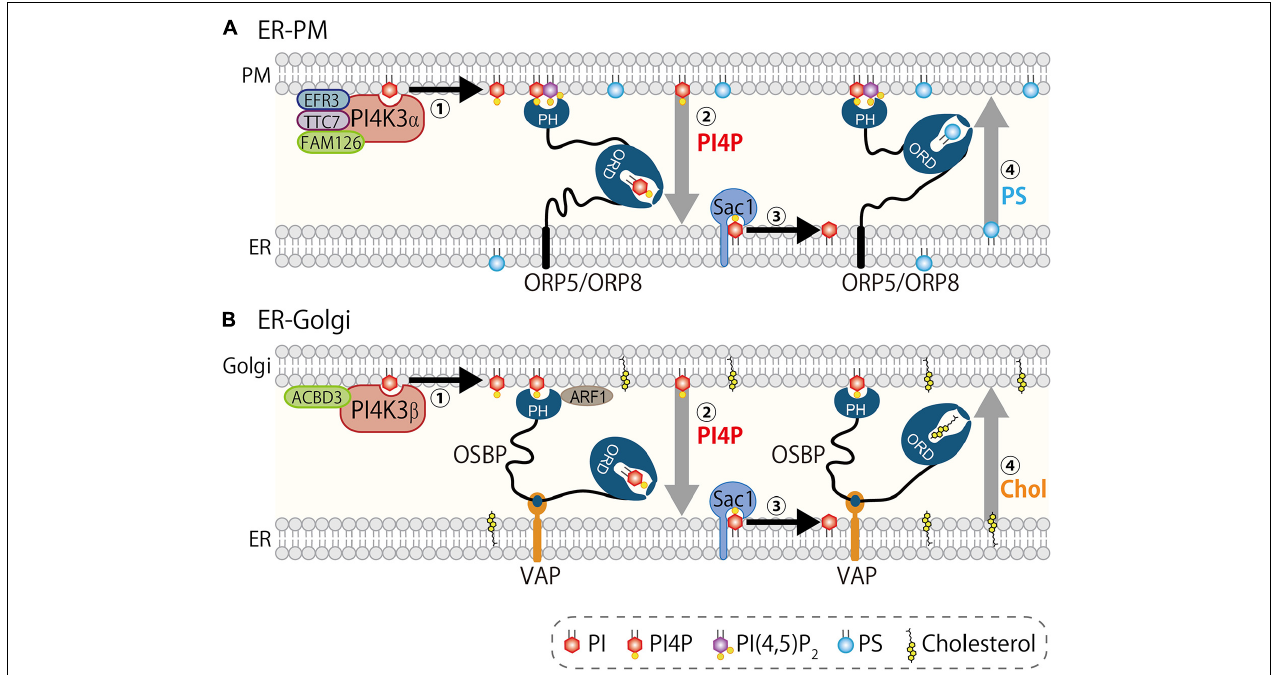
FIGURE 3 | PI4P-driven lipid countertransport at MCSs. PI4P drives lipid countertransport mediated by ORP5/8 at ER–PM MCSs (A) and by OSBP at ER–Golgi MCSs (B) . (A) PI4K3 α complex including EFR3A/B, TTC7A/B, and FAM126A/B synthesizes and concentrates PI4P at the PM (step 1). ORP5/8, both of which are anchored to the ER, form MCSs via interaction with PI4P and PI(4,5)P 2 by PH domain, and transport PI4P (driver-ligand) from the PM to the ER (step 2). Sac1 dephosphorylates PI4P to PI, which keeps the concentration of PI4P low at the ER (step 3). ORP5/8 transport PS (cargo-ligand) from the ER to the PM. (B) PI4K3 β generates PI4P upon recruitment to the Golgi by regulatory proteins including Arf1 (step 1). Oxysterol-binding protein (OSBP) is recruited to the ER–Golgi MCSs via PH domain that interacts with PI4P and ACBD3 and/or Arf1 on the Golgi membranes and FFAT-motif that binds vesicle-associated membrane protein (VAMP)-associated protein A/B (VAPA/B). Then, OSBP mediates transport of PI4P (driver-ligand) from the Golgi to the ER (step 2). Sac1 hydrolyzes PI4P to PI (step 3). OSBP transports cholesterol (cargo-ligand) to Golgi (step 4). Synthesis and hydrolysis of PI4P by PI4Ks and Sac1 establishes a concentration gradient of this lipid between the ER and the PM/Golgi, which determines the flow of driver-ligand PI4P to the ER and counterflow of cargo-ligands from the